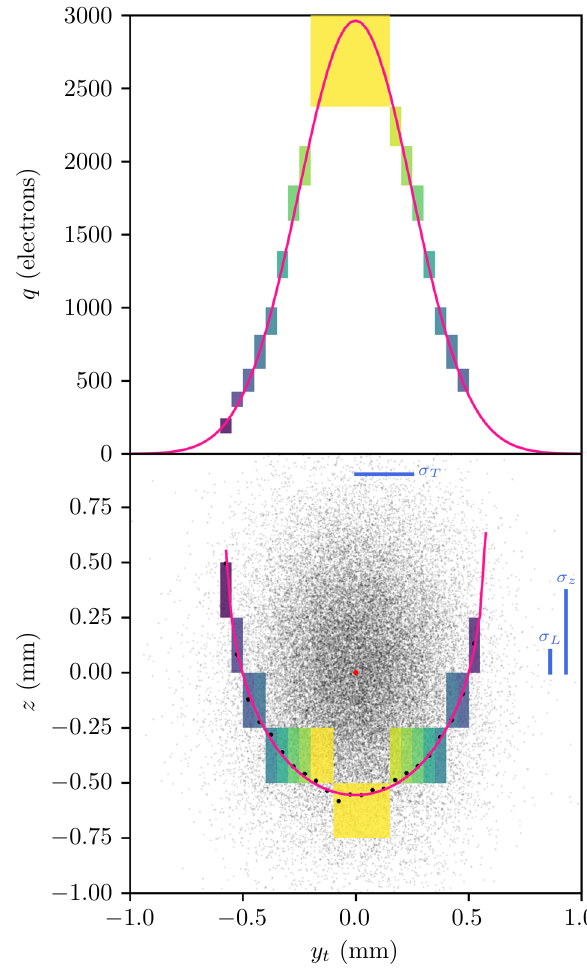
Fig. 4 The charge profile (top) and shell (bottom) for a slice of a sim- ulated charge cloud (gray dots) with θ = 40 ◦ , σ T = 250 µ m, and σ = 100 µ m. Charge is digitized using a pixel pitch of 50 µ m in y , L 250 µ m in z , and with the charge scale (encoded by color/shade) from a FE-I4b calibration. The profile and shell fits, using Eqs. (13) and (14), are shown with solid magenta lines. Due to the high inclination of the track, the dispersion in z is dominated by the charge projection effect, as can be seen by comparing the bars representing σ L and σ z on the right of the bottom plot. The red dot in the center of the bottom plot marks the true track center (μ, z 0 ) . The black points indicate the true threshold-crossing position in z for each pixel before digitization